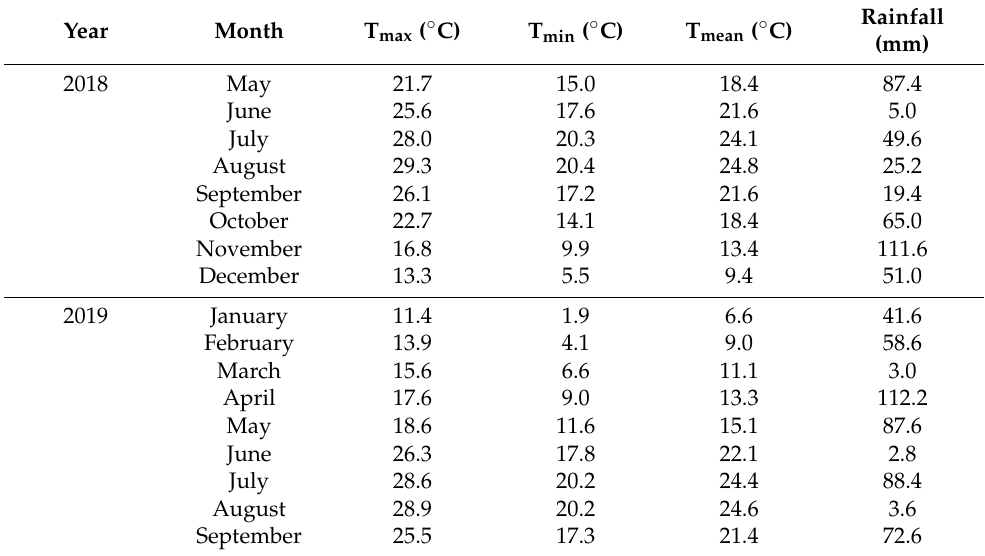
Table 2. Monthly cumulative (mm) rainfall and mean temperatures (T mean , T max , and T min ) through- out the entire experimental period (May 2018–September